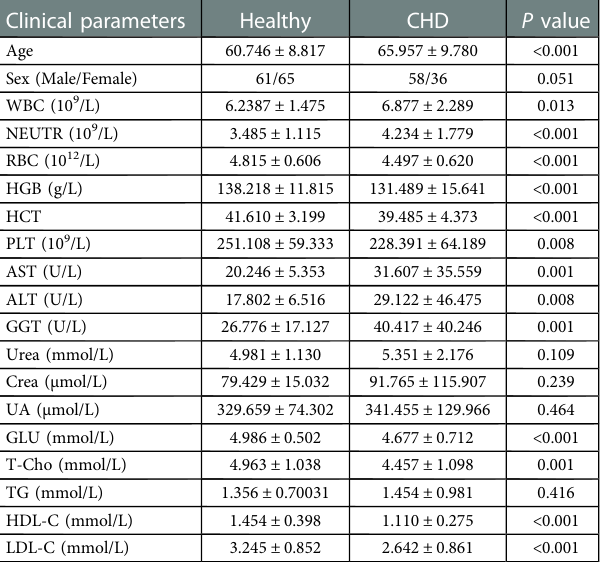
TABLE 1 Clinical parameters of the CHD patients and healthy controls. Clinical